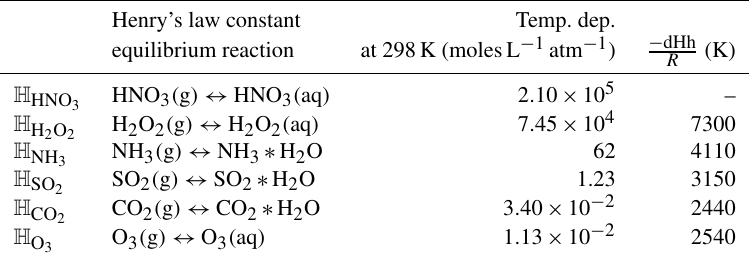
Table C3. Dissolution constants and their temperature dependence coefficients (taken from Kreidenweis et al.,